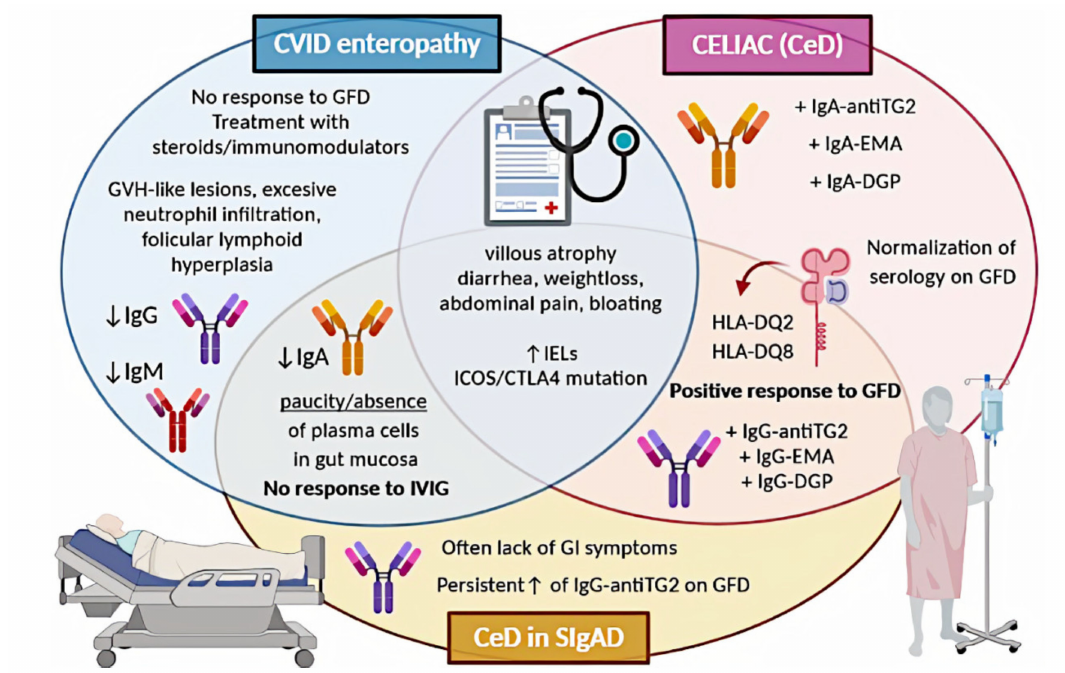
Figure 3. Comparrison of CeD, CeD in SIgAD, and CVID enteropathy. CVID, common variable immunodeficiency; CeD, celiac disease; SIgAD, selective IgA deficiency; GFD, gluten-free diet; GVH, graft-versus-host; IVIG, intravenous immunoglobulin; IELs, intraepithelial lymphocytes; antiTG2, anti-tissue transglutaminase; EMA, endomysial antibodies; DGP, deamidated glutin peptides; GI,